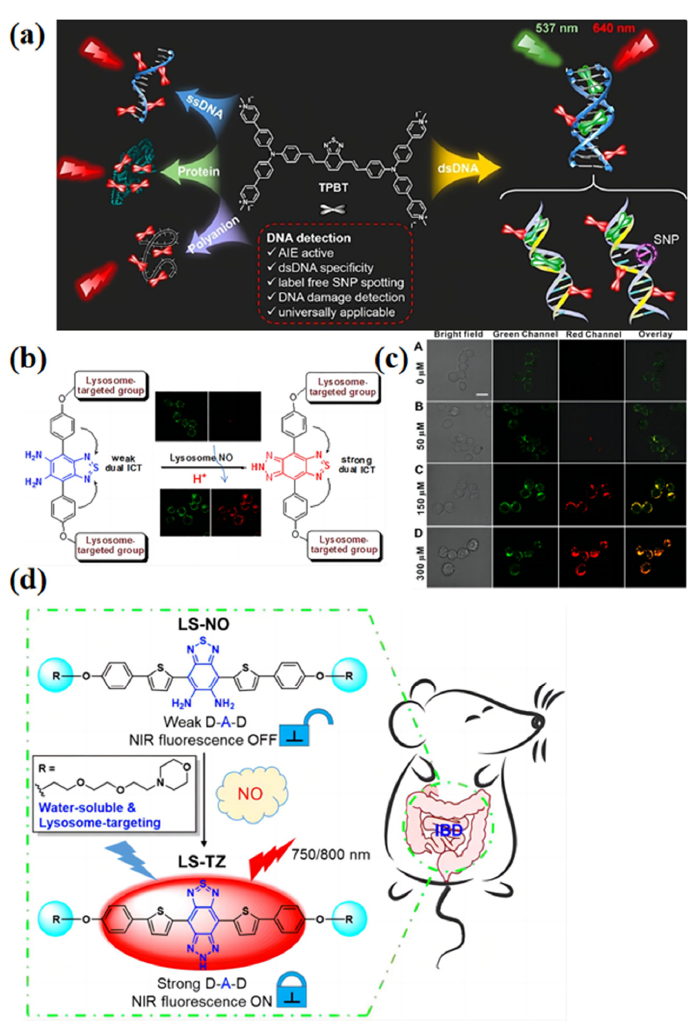
Figure 8. ( a ) Molecular structure of TPBT and its various emissions upon binding with different polyanionic macromolecules. Adapted with permission from [78]. ( b ) Molecular structure of MBTD. Adapted with permission from [79]. ( c ) CLSM imaging of RAW 264.7 cells treated with MBTD at various DEANO concentrations (0, 50, 150, 300 μ M) for 1 h. Adapted with permission from [79]. ( d ) Schematic illustration of a water ‐ soluble D − A − D ‐ type NIR fluorescent probe named LS ‐ NO for real ‐ time detection of NO in the IBD model in vivo. Adapted with permission from [80].